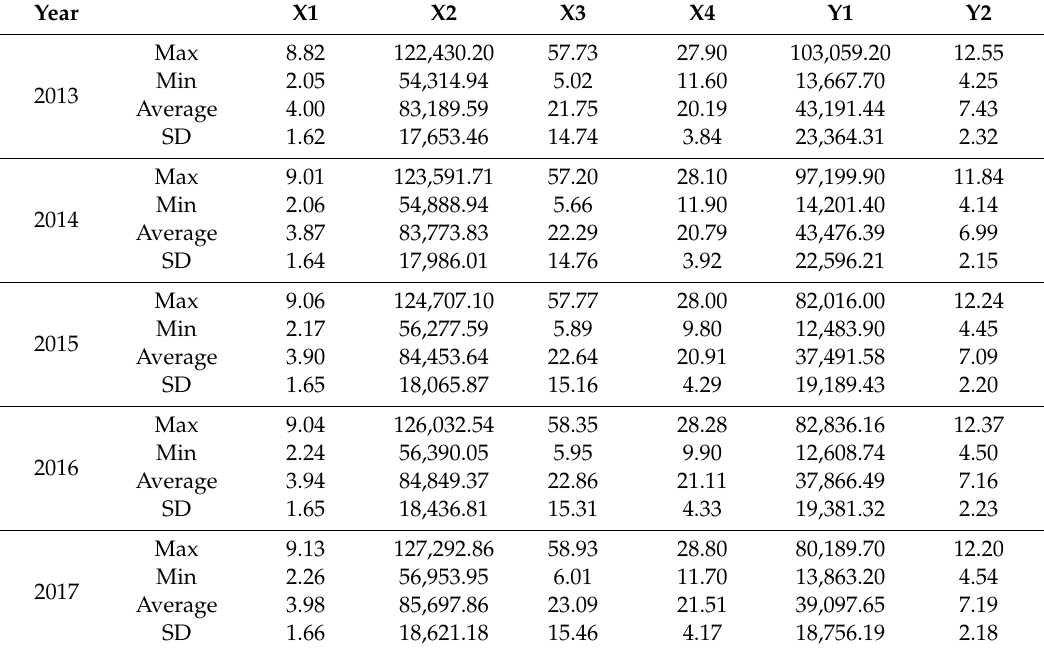
Table 4. Summary of data for input and output variables in the time period